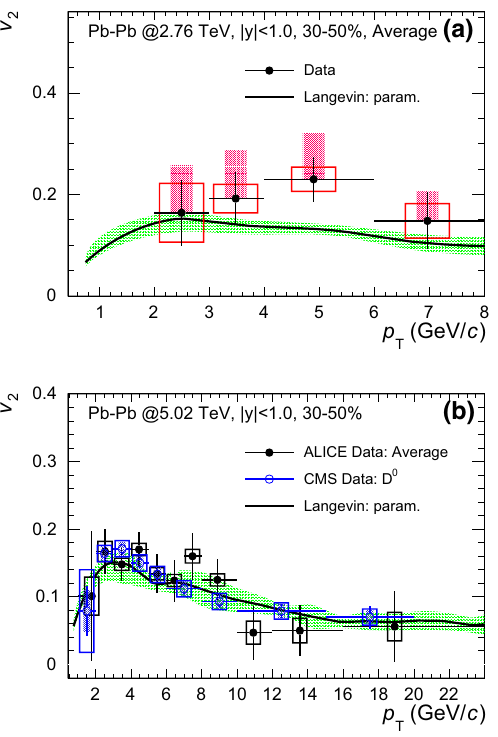
Fig. 5 Comparison between experimental data (red [42], black [43] and blue boxes [58]) and LGR Model-B calculations (solid black curve with green uncertainty band) for the elliptic flow v 2 of non-strange D-meson at mid-rapidity ( | y | < 0 . 5) in the 30–50% centrality Pb–Pb √ √ s NN = 2 . 76 TeV and b s NN = 5 . 02 collisions at a